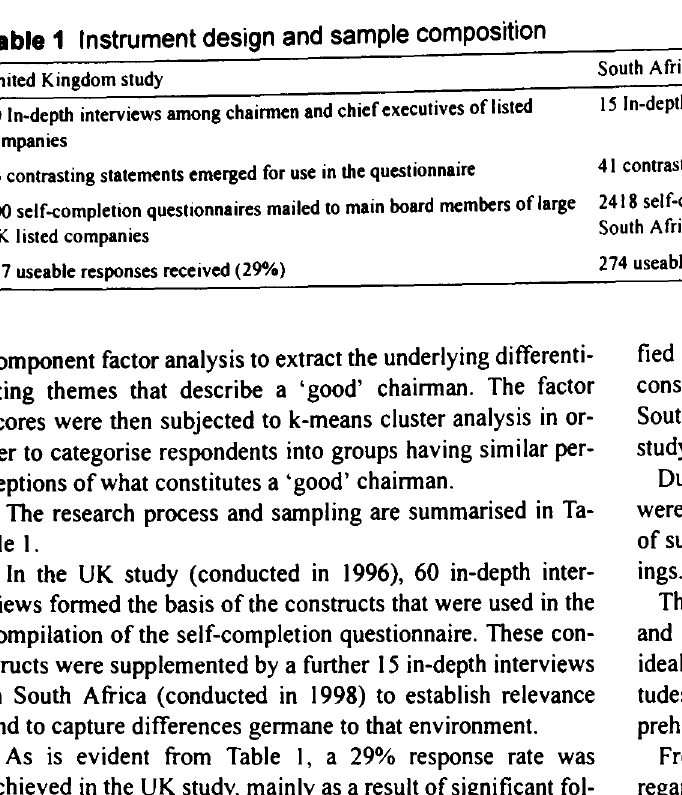
Table 1 Instrument design and sample